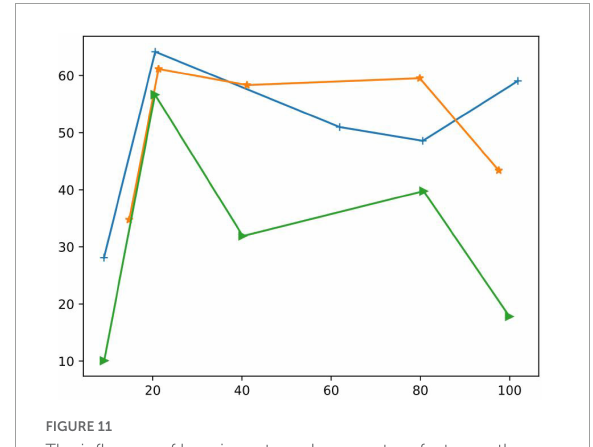
FIGURE11 The influence of learning rate and momentum factor on the model.